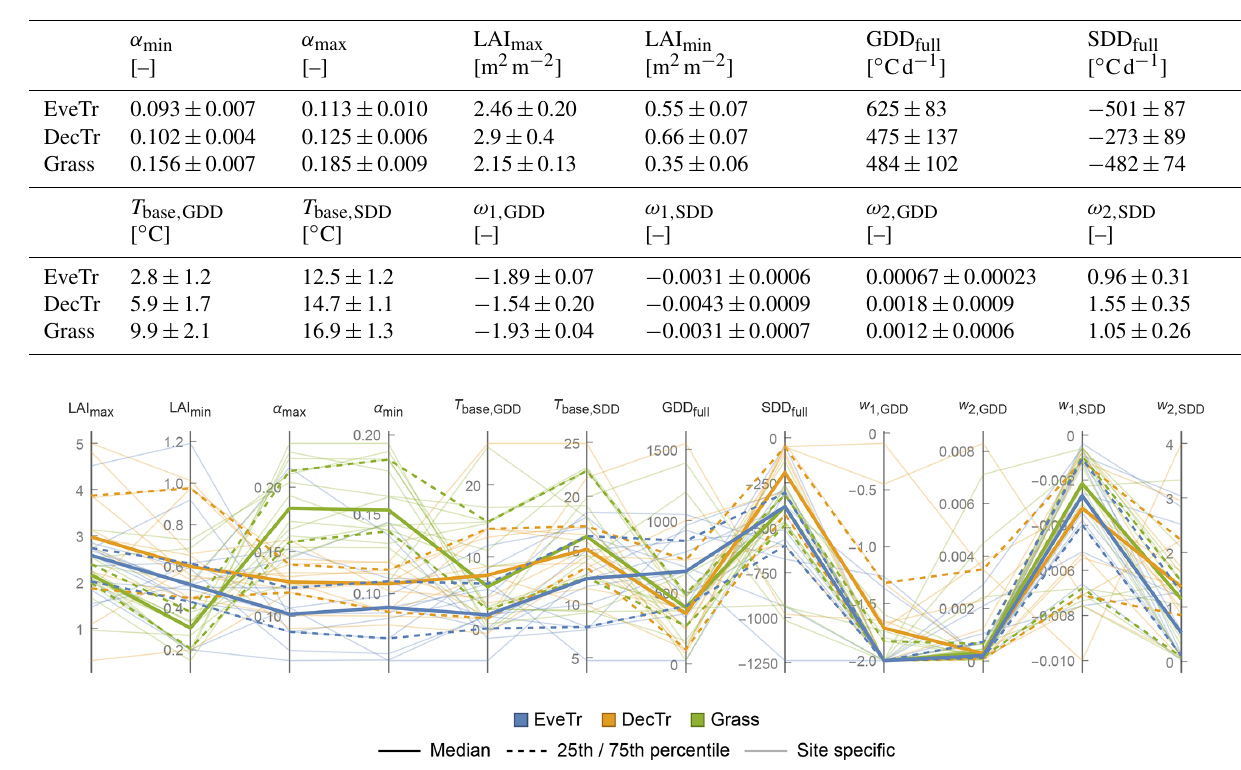
Table 5. Inter-site variability within the three vegetation classes of LAI- and albedo-related parameters (Eq. 4, Sect. 4.1) shown by mean and standard deviation. For individual site and PFT parameters see Appendix C (for digital version see Sun et al., 2021). Median and interquartile range (IQR) see Fig. 5.